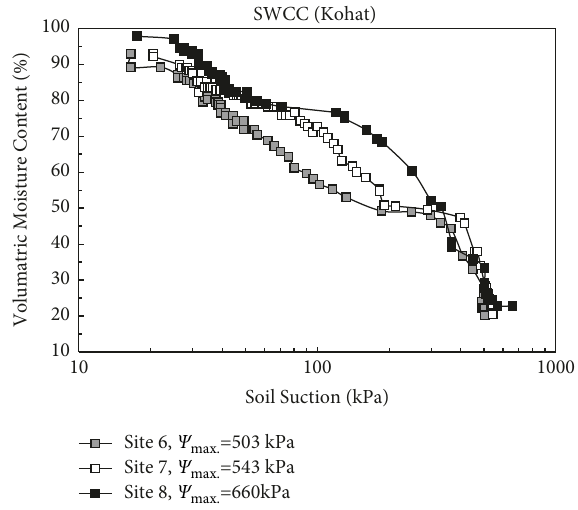
Figure 5: Field-based SWCCs for sites S expansive soil.